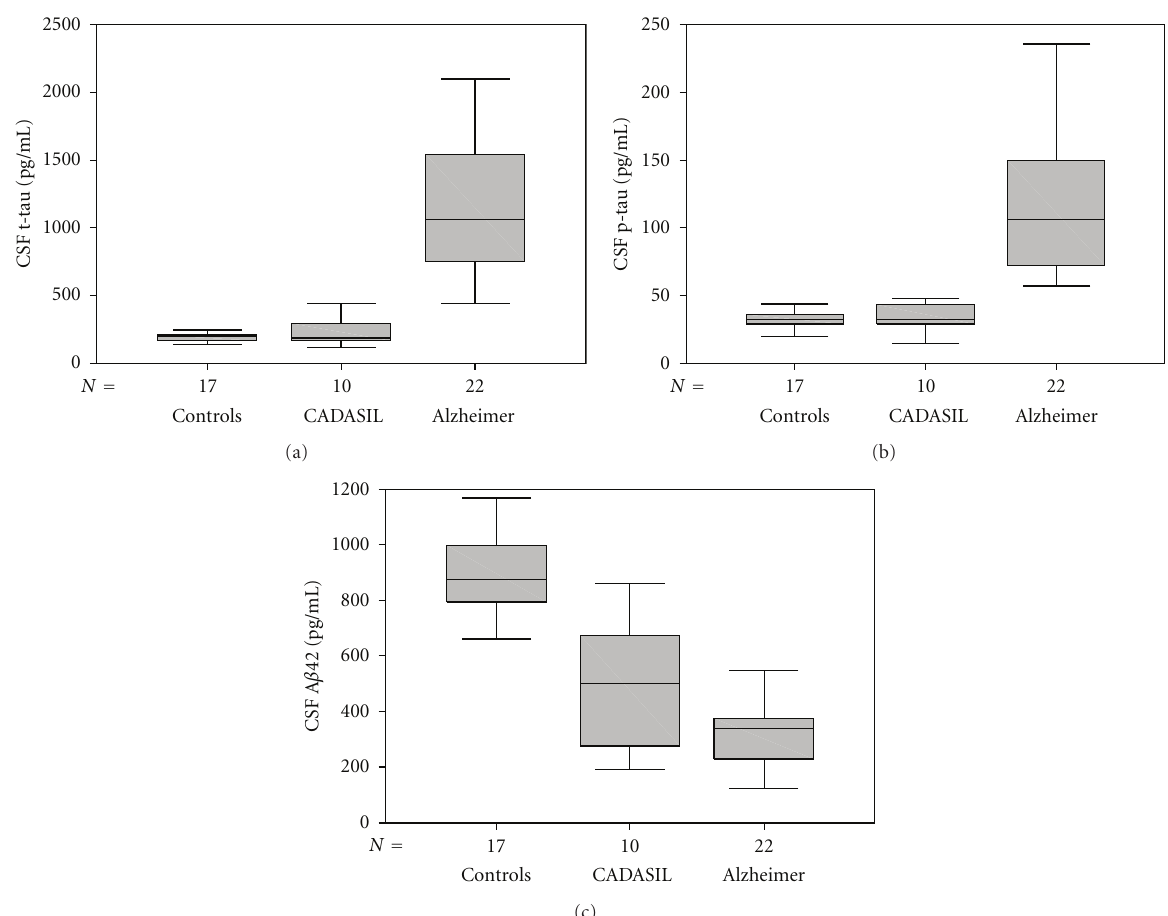
Figure 1: Box plots of CADASIL and Alzheimer patients and control subjects. They include median (horizontal line within box), interquartile interval, that is, 25th to 75th percentile (grey box) and range of variation (whiskers): (a) t-tau data, (b) p-tau data, and (c) A β 1-42